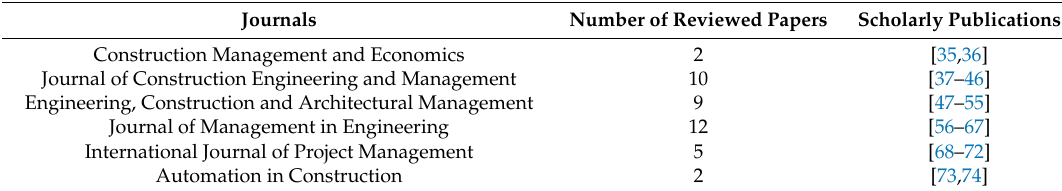
Table 1. Literature of construction schedule performance within selected